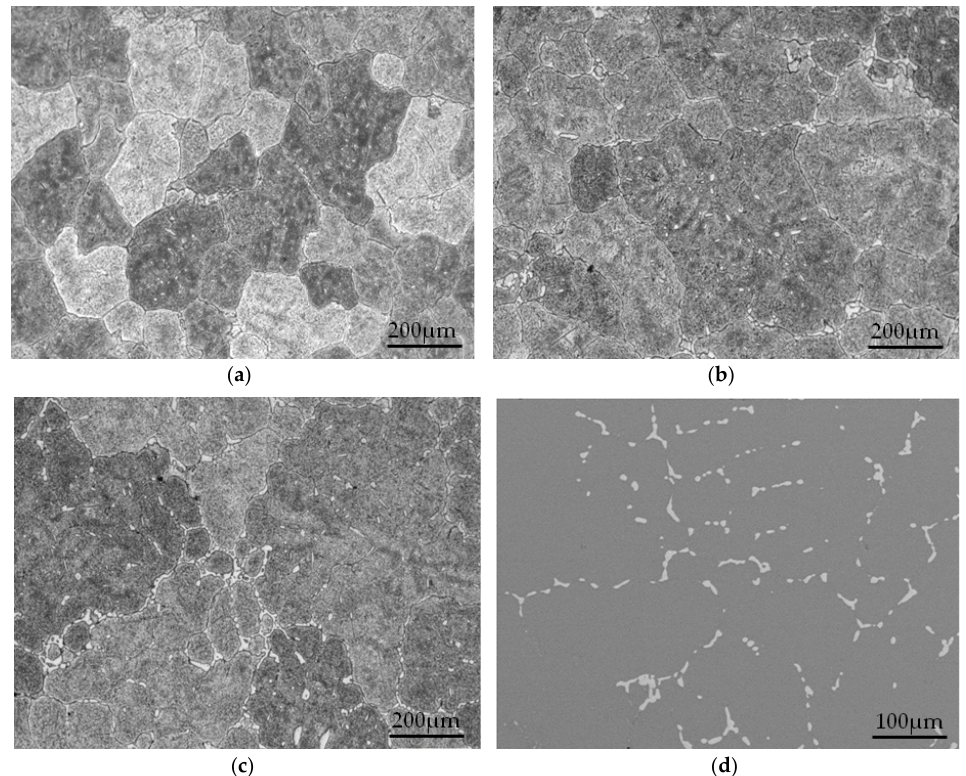
Figure 4. Micrographs of homogenized 2219 aluminum alloys with different Cu contents: Optical images ( a ) 5.56%, ( b ) 6.15%, ( c ) 6.52%, and ( d ) SEM image of 6.15%.